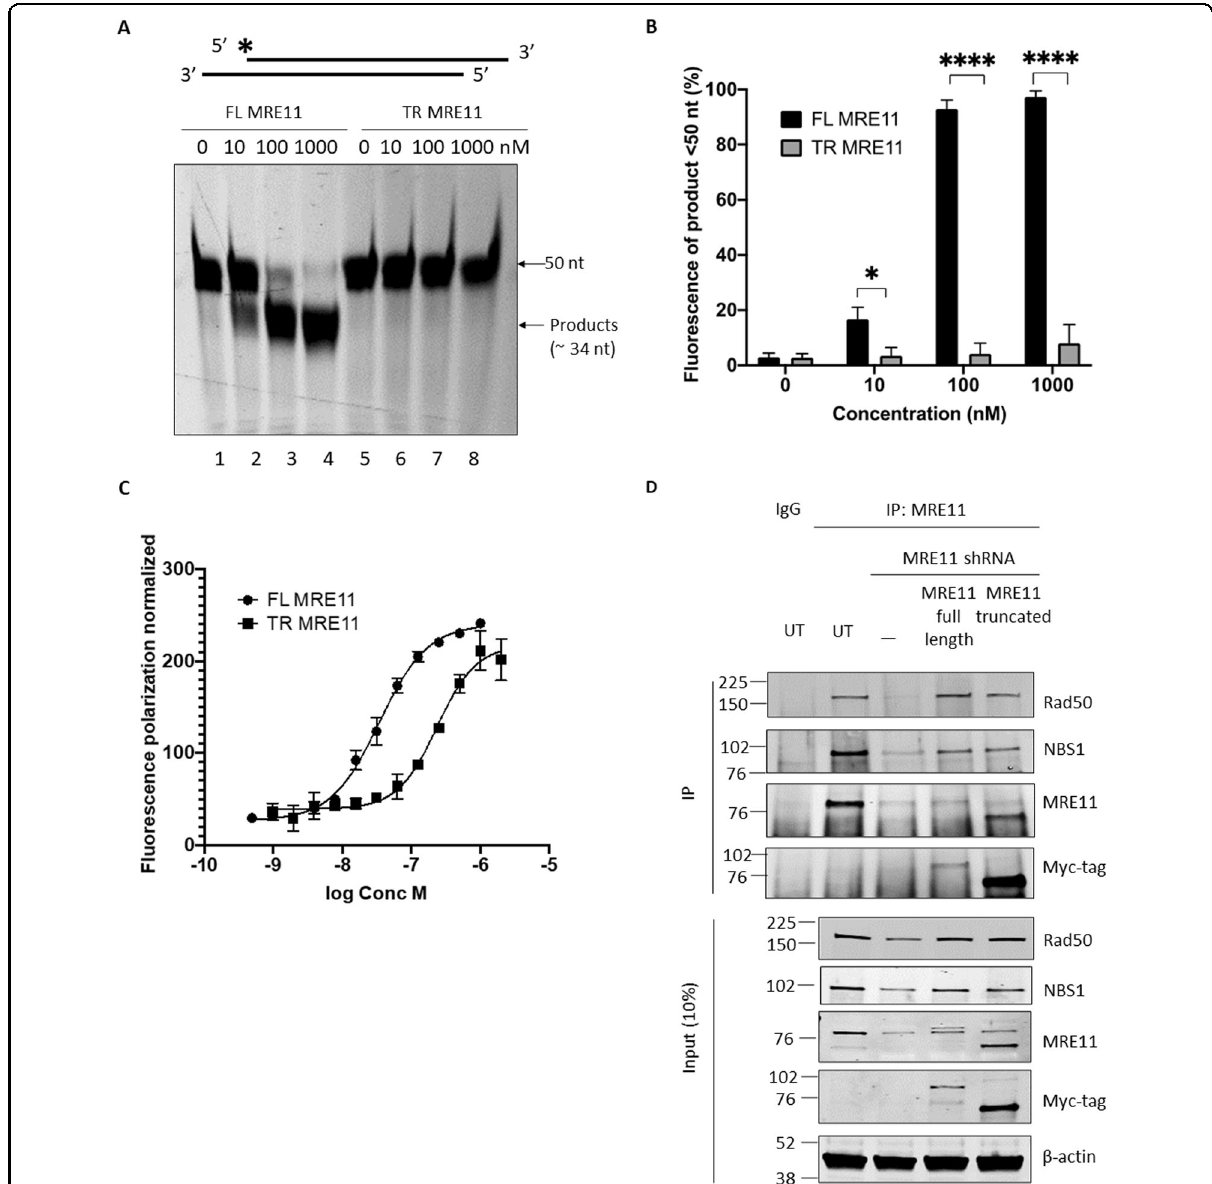
Fig. 3 TR-MRE11 lacks nuclease and DNA binding activities. A Nuclease assays of FL-MRE11 (lane 1, 2, 3, 4) and TR-MRE11 (lane 5, 6, 7, 8) on 3 ′ - overhang DNA substrates ( n = 3). The FL-MRE11 shows clear dose-dependent nuclease activity which is absent in TR-MRE11. B Quanti fi cation of nuclease activity data in ( A ). Error bars represent SEM ( P < 0.0001 (****), P < 0.05 (*)). C Measurement of fl uorescence polarisation ( n = 1). The apparent dissociation constant for FL-MRE11 was 34.56 nM, whilst TR-MRE11 showed signi fi cantly reduced DNA binding (242.15nM). D TR-MRE11 was still able to ef fi ciently interact with RAD50 and NBS1, and this has been shown through immunoprecipitated MRE11 from VM-CUB1 protein